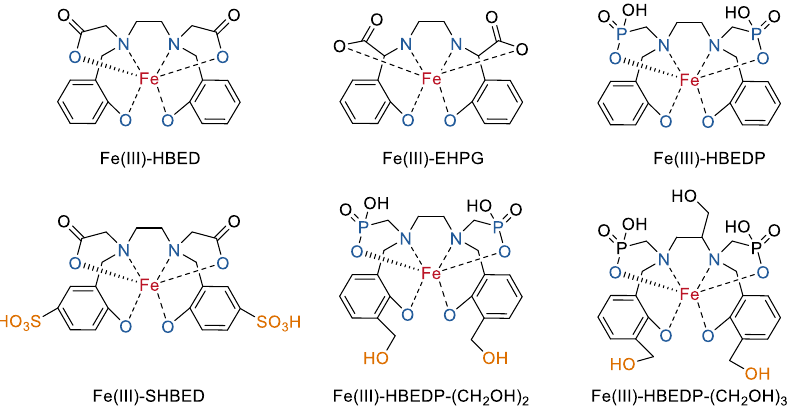
Figure 1. Chemical structures of mononuclear Fe(III) complexes with open ligands based on HBED and its derivatives [33].